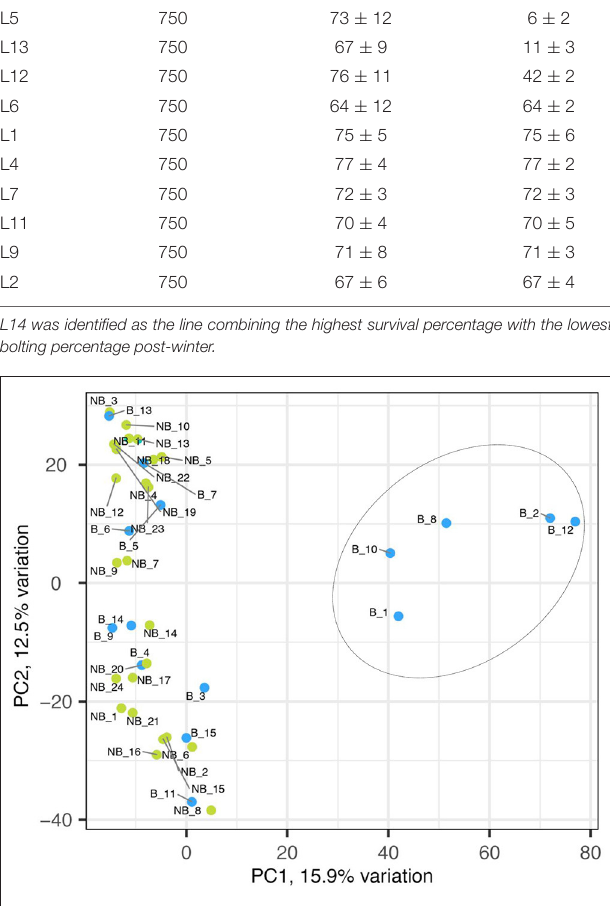
FIGURE 2 | Principal component analyses of 10,924 SNP markers on bolter and non-bolter phenotypes of L14 plants. Each dot represents a sample, and the blue color represents bolters (B) while the green color represents non-bolters (NB). The first two axes of the PCA explain 28% of the overall variance and separated the bolter and non-bolter phenotypes.